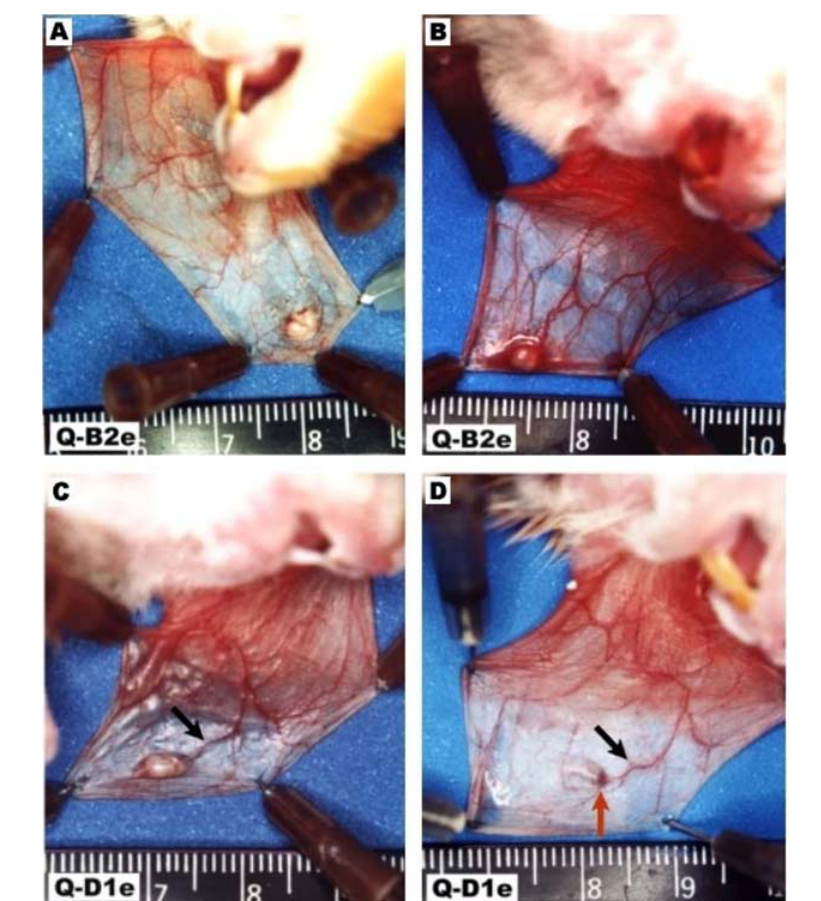
FIGURE 6 - Macroscopic aspect of grafted keloid fragments at 12 and 42 days. A) Immediate post-operative of the fragment Q-B2e. B) At 12 days, intensive vascularization circumjacent to the grafted keloid “+++” (Q-B2e), and presence of new vascular branches towards the graft. C) Immediate post-operative view of the fragment Q-D1e. D) At 42 days, absence of vascularization around the grafted keloid fragment (Q-D1e), and a clear presence of dark-brown pigmentation are observed on the keloid (vertical arrow). The blood vase towards the keloid is a preexisting one (tilted arrow).